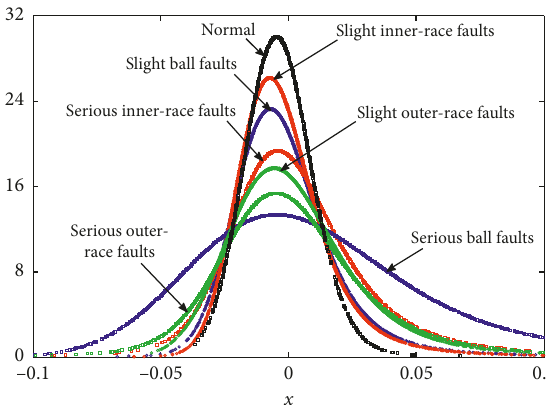
Figure 10: The PDFs of seven signals.